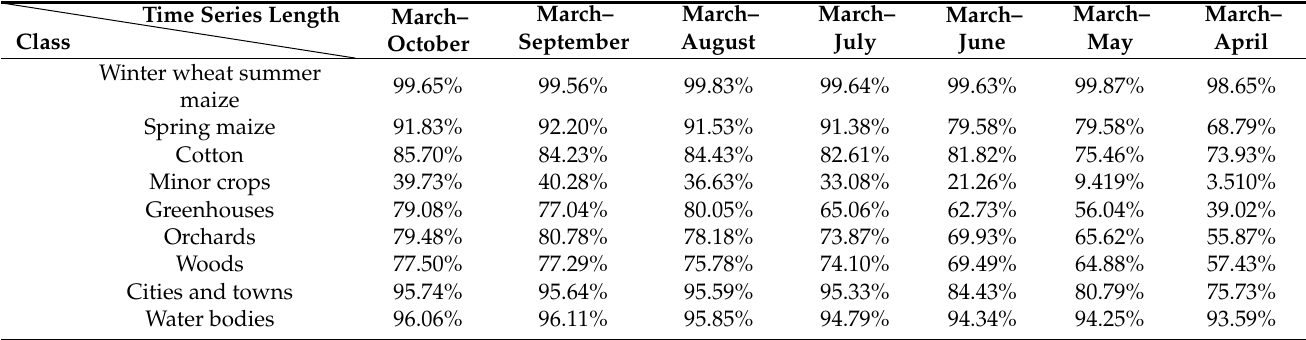
Table A3. Crop identification accuracy of different length NDVI time series in